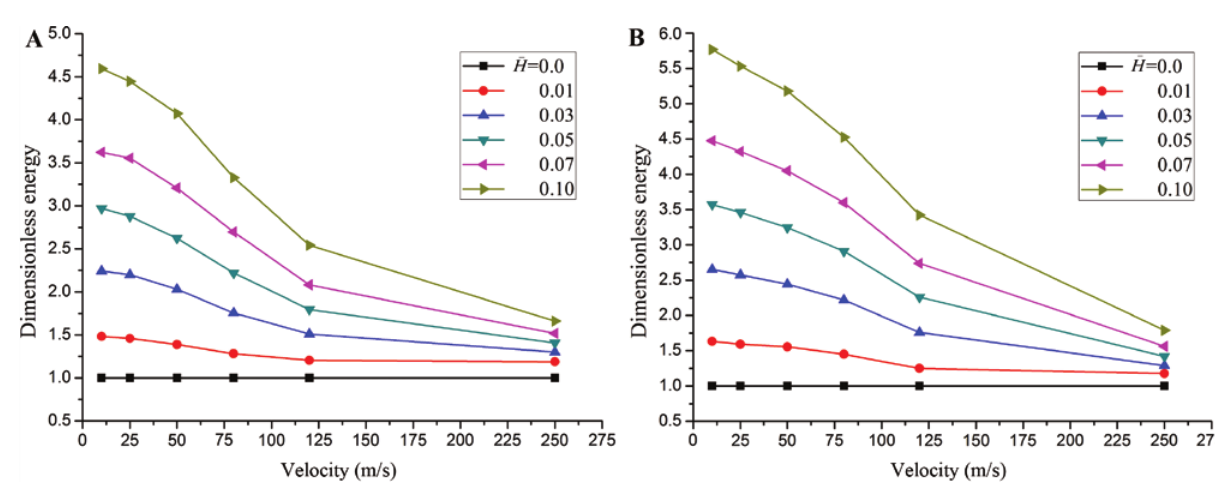
E ) at 50% (A) and 70% (B) crushing strain, respectively. pp